Question: Produce a descriptive caption suitable for publication.
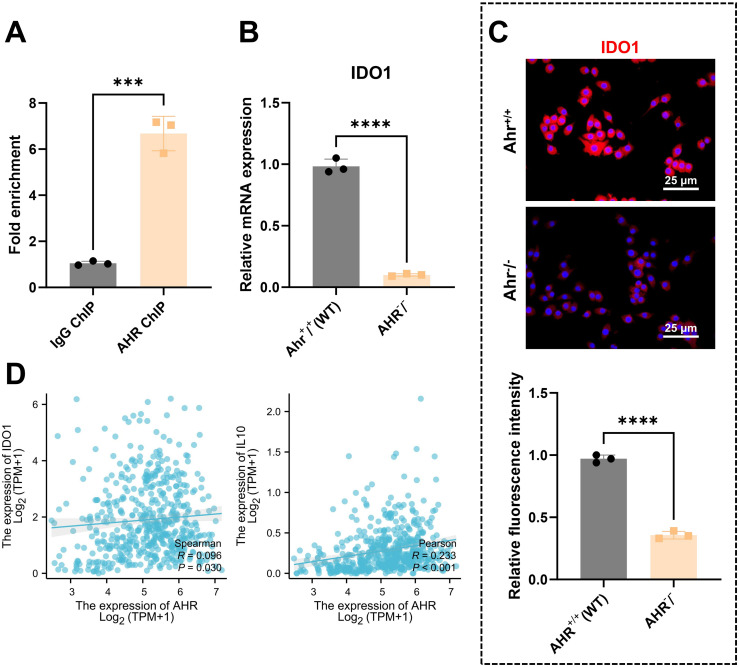
Answer: AHR regulates IDO1 transcription and the expression of immunosuppression-related genes. (A) ChIP-qPCR analysis of AHR antibody versus IgG control demonstrates differential enrichment at the IDO1 promoter region; (B) RT-qPCR quantification of IDO1 mRNA expression in Ahr+/+ and Ahr-/- macrophages; (C) IF staining of IDO1 protein in Ahr+/+ and Ahr-/- macrophages, with quantification of relative fluorescence intensity; bar = 25 μm; (D) Correlation analysis of AHR expression with IL10 and IDO1 levels in the TCGA-THCA cohort. Cell-based experiments were carried out in triplicate. ns, p > 0.05; *** p < 0.001; **** p < 0.0001.